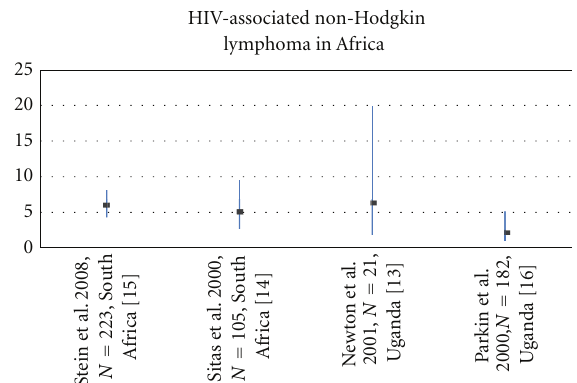
Figure 1: Odds Ratios (ORs) with 95% Confidence Intervals (CIs) for the association between NHL and HIV infection in sub-Saharan